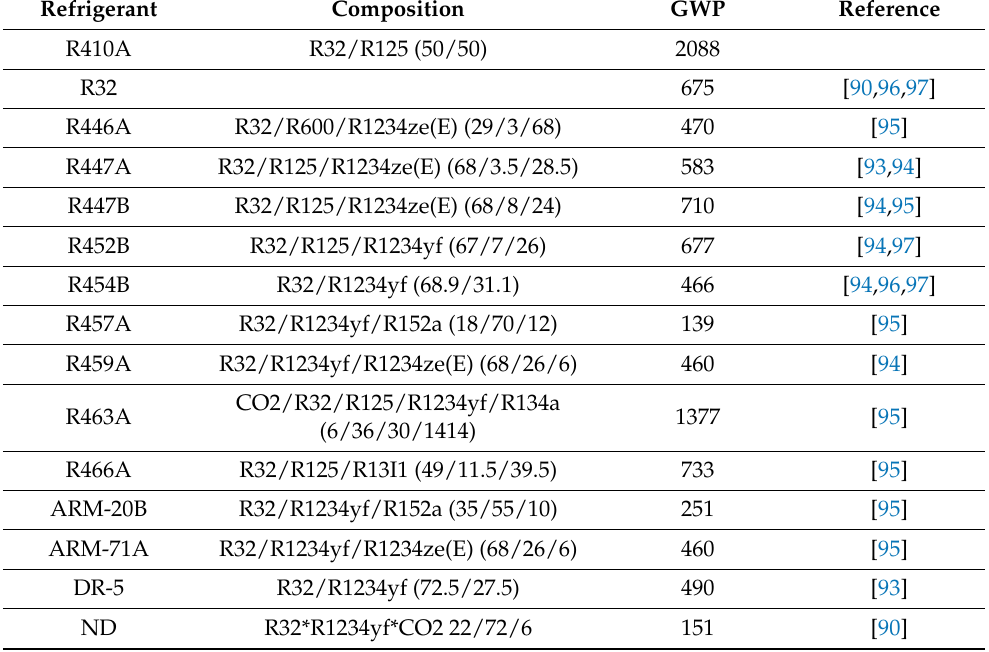
Table 3. R410A proposed